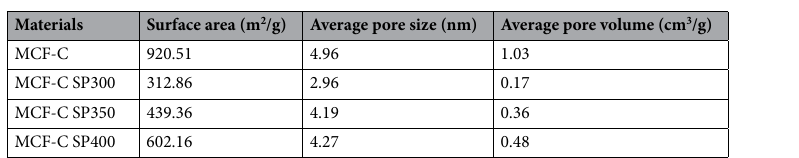
Table 1. Physical properties of the fresh and spent catalyst with different reaction temperatures.